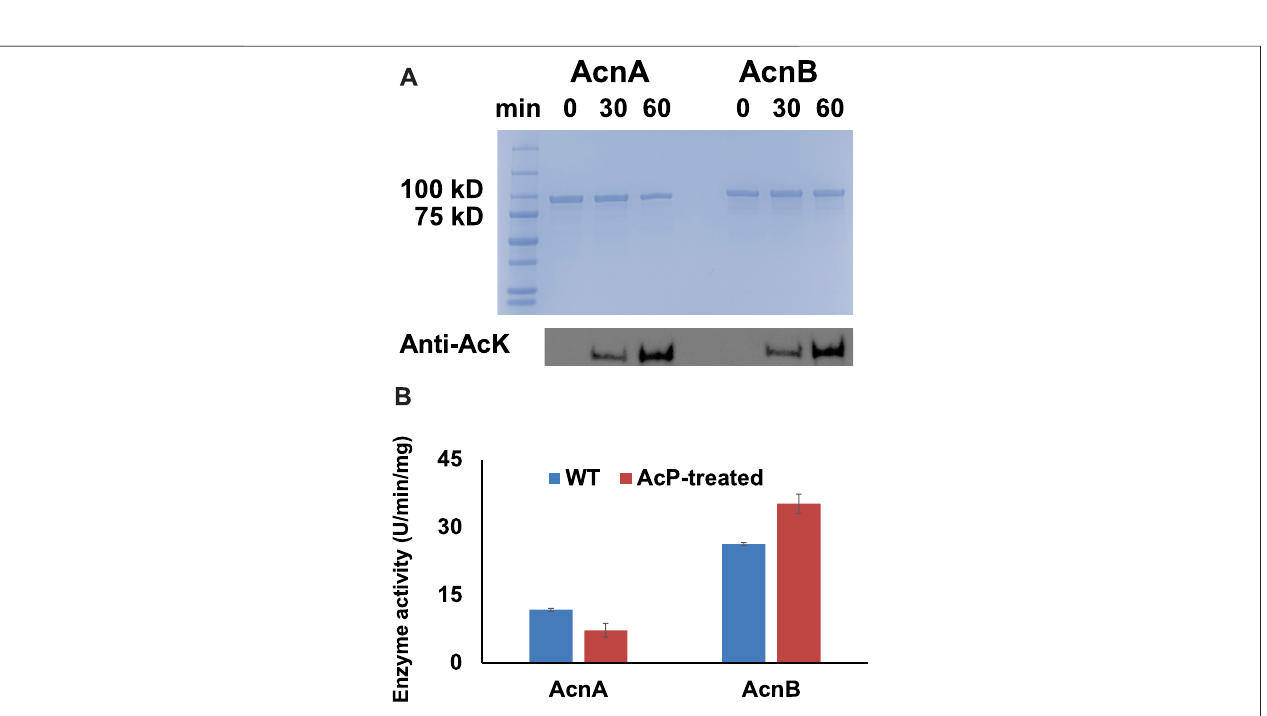
Frontiers in Chemistry |